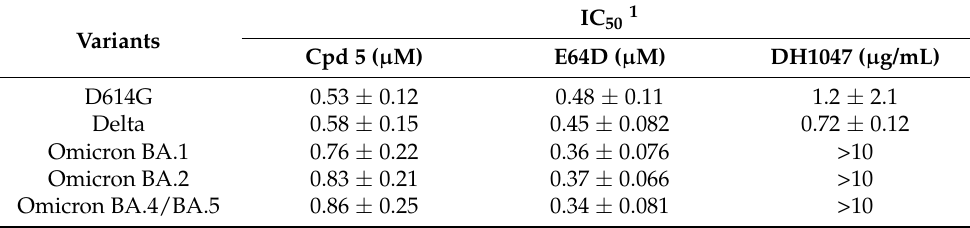
Table 2. Effects of compound 5 against SARS-CoV-2 variants (spike-pseudotyped